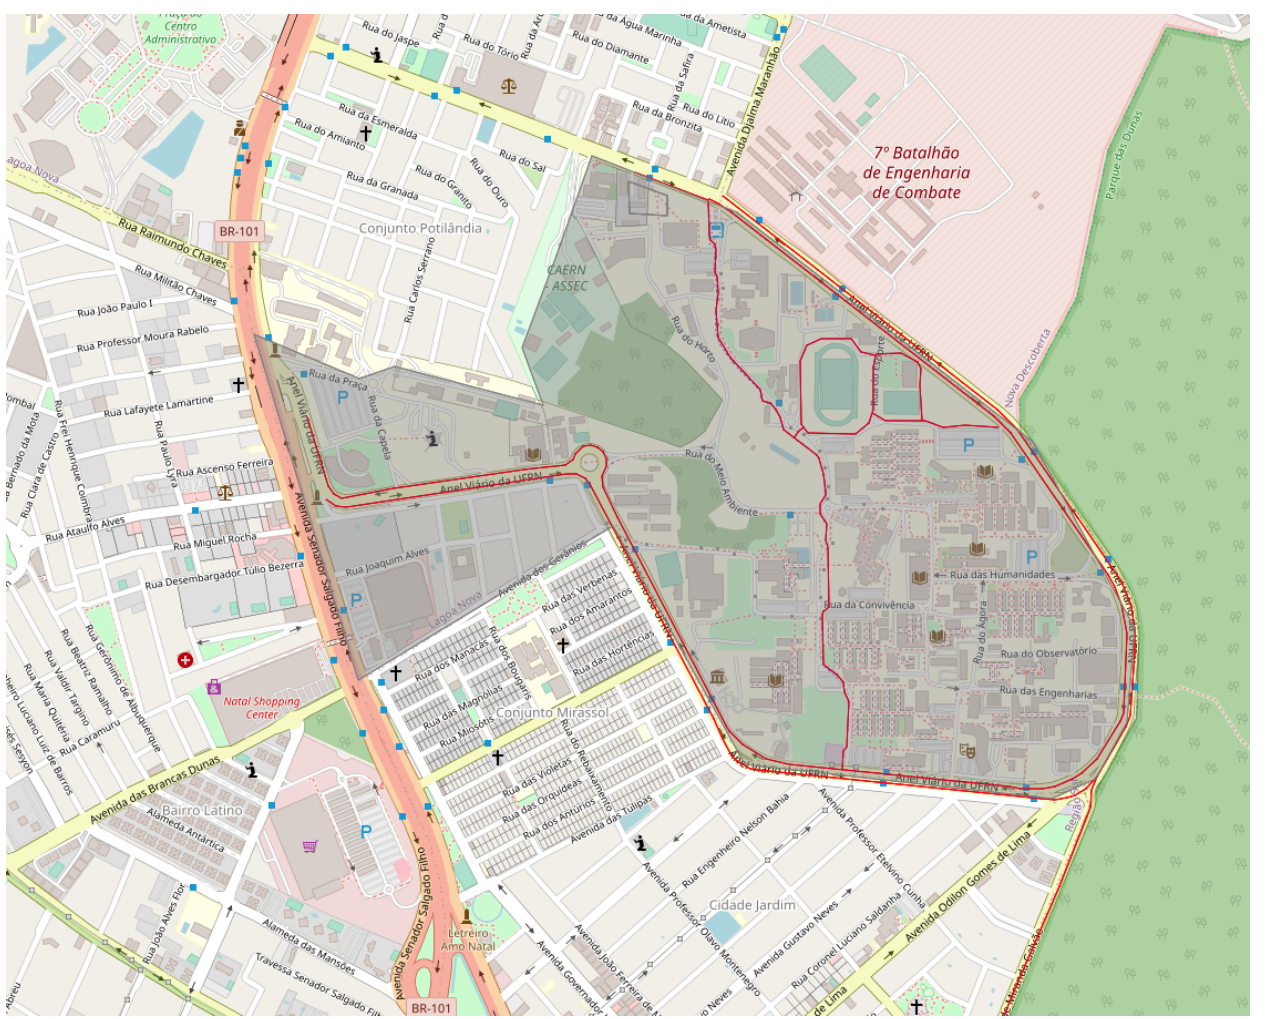
Figure 8. Map 1: UFRN Central Campus (grey area) and its cycle lanes (red lines). Source: [33,34]. Figure 9 presents the socioeconomic characterization of the UFRN central